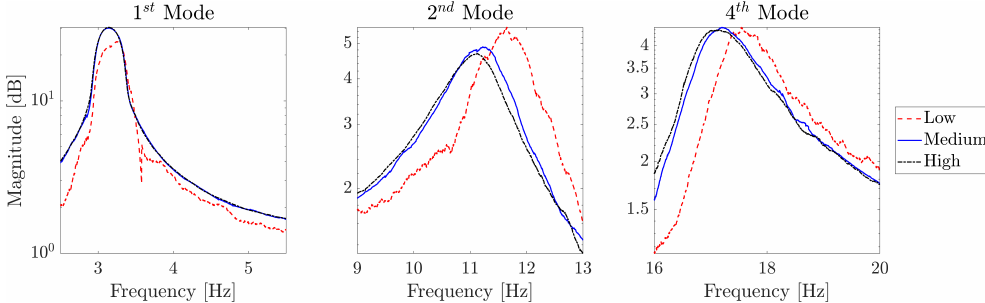
Figure 23. Full wing: comparison of the FRFs of channel #4L for the two input scenarios near resonances. Table 11. Full wing: natural frequency and damping ratio